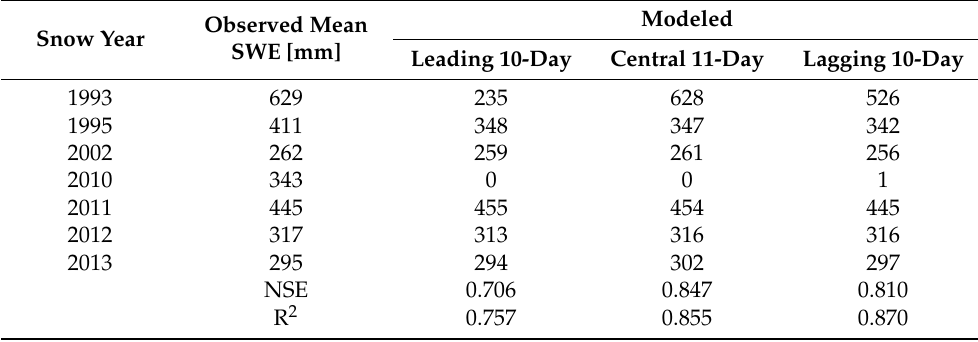
Table A2. Comparison of breakpoint prediction values of mean SWE for slope difference threshold of 0.5.